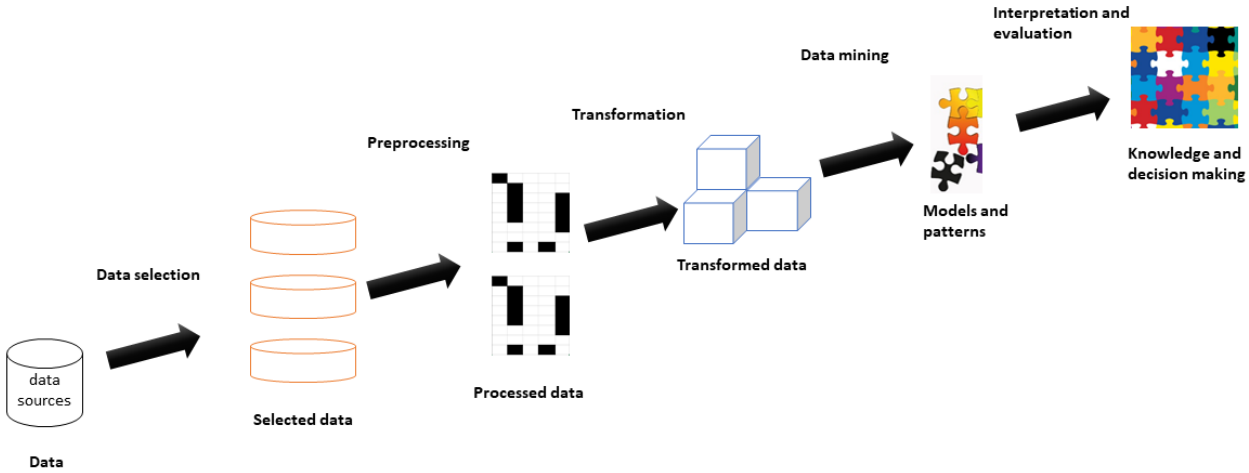
Figure 1. Face-to-face education model, with the teacher as the main actor of